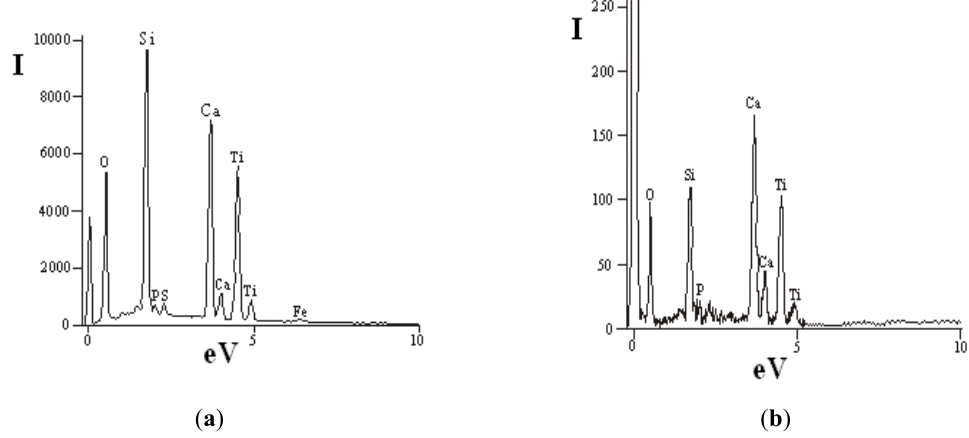
Figure 6. Energy-dispersive analysis of concentrate particle surface: ( a ) planetary mill; ( b ) initial concentrate.